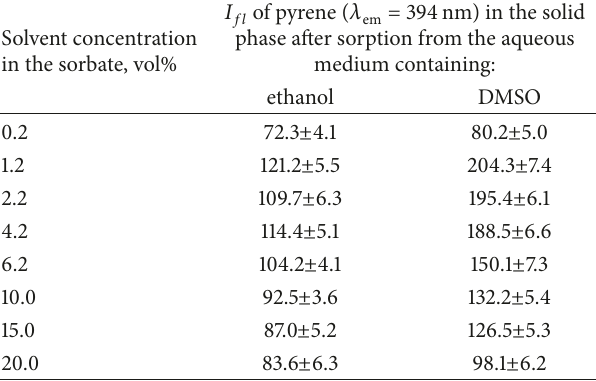
Table 2: The fluorescence intensity of pyrene sorbed onto CDA matrices from aqueous media containing the solvent with several concentrations.